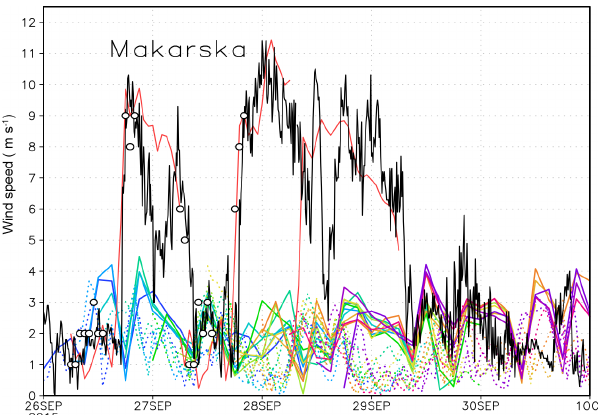
Figure 10. Wind speed in Makarska (43.28 ◦ N, 17.02 ◦ E) from 00:00UTC 26 September 2015 until 00:00UTC 1 October 2015, measured by the local automatic station with 10min intervals (black), the local synoptic station (black circles) and forecasts: HR-alaro-22 (red), HR-alaro-88 (full lines) and HR-alaro-HRDA (dashed) are plotted in rainbow sequence depending on the analysis time (blue for the run starting at 00:00UTC 26 September 2015, light blue for 06:00UTC the same day,